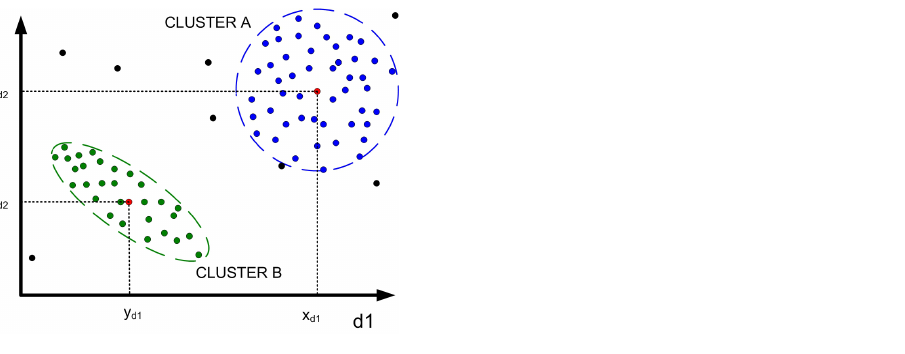
Figure 1. Example of type 1 segmentation. Two clusters or classes ( A and B ) and their respective centroids, ( x 1 , y 1 ) and ( x 2 , y 2 ) , are formed on a two-dimensional dataset.